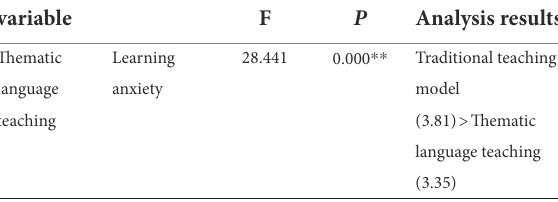
TABLE 3 Difference analysis of thematic language teaching and learning anxiety. variable F P Analysis